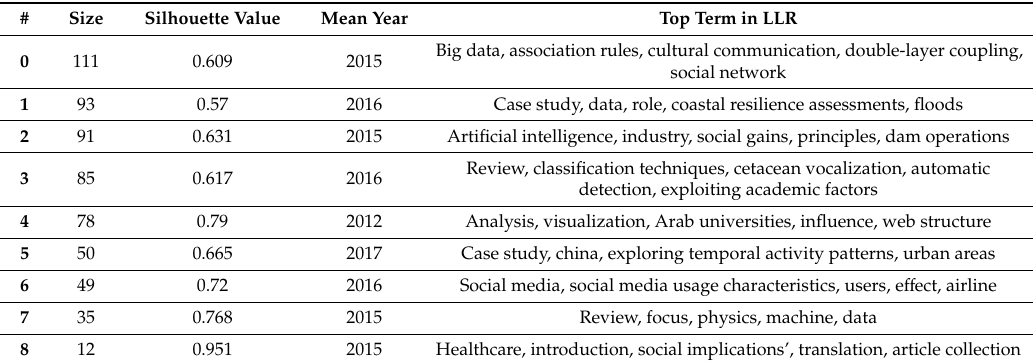
Table 7. The details of keywords in